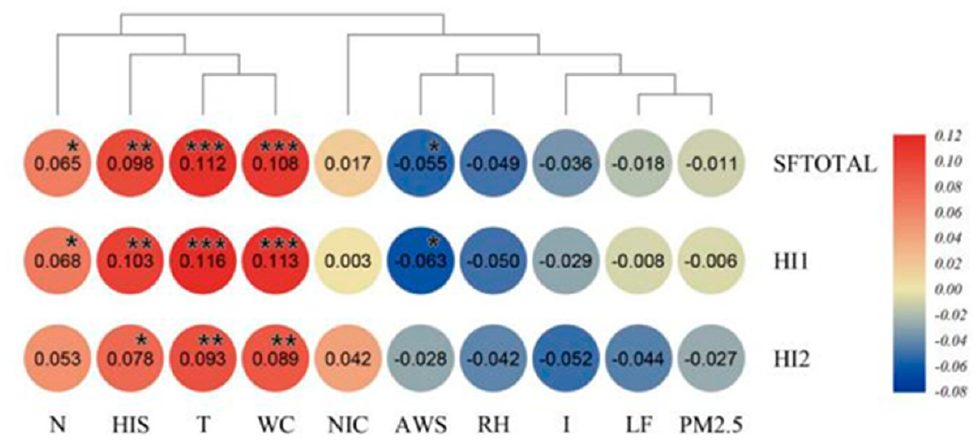
Figure 4. Correlation between total score, mental health, physical health, and environmental factors. Note: “***” indicates a significant correlation at the 0.001 level, “**” indicates a significant correlation at the 0.01 level, “*” indicates a significant correlation at the 0.05 level.